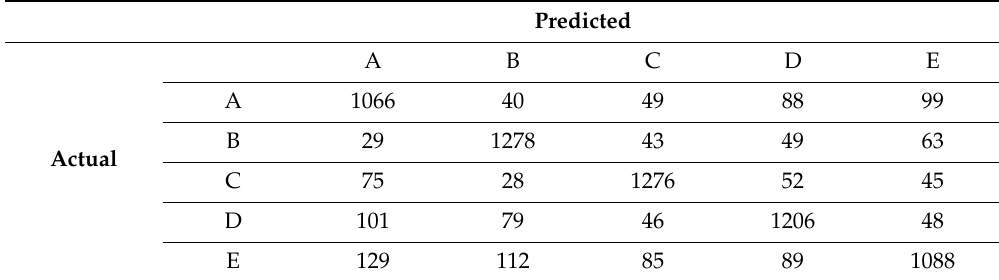
Table 4. Confusion matrix of 5 classes’ prediction.